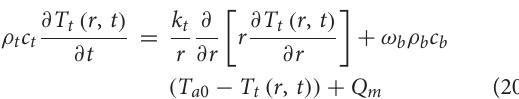
(forearms) assuming maximum of temperature at the axis